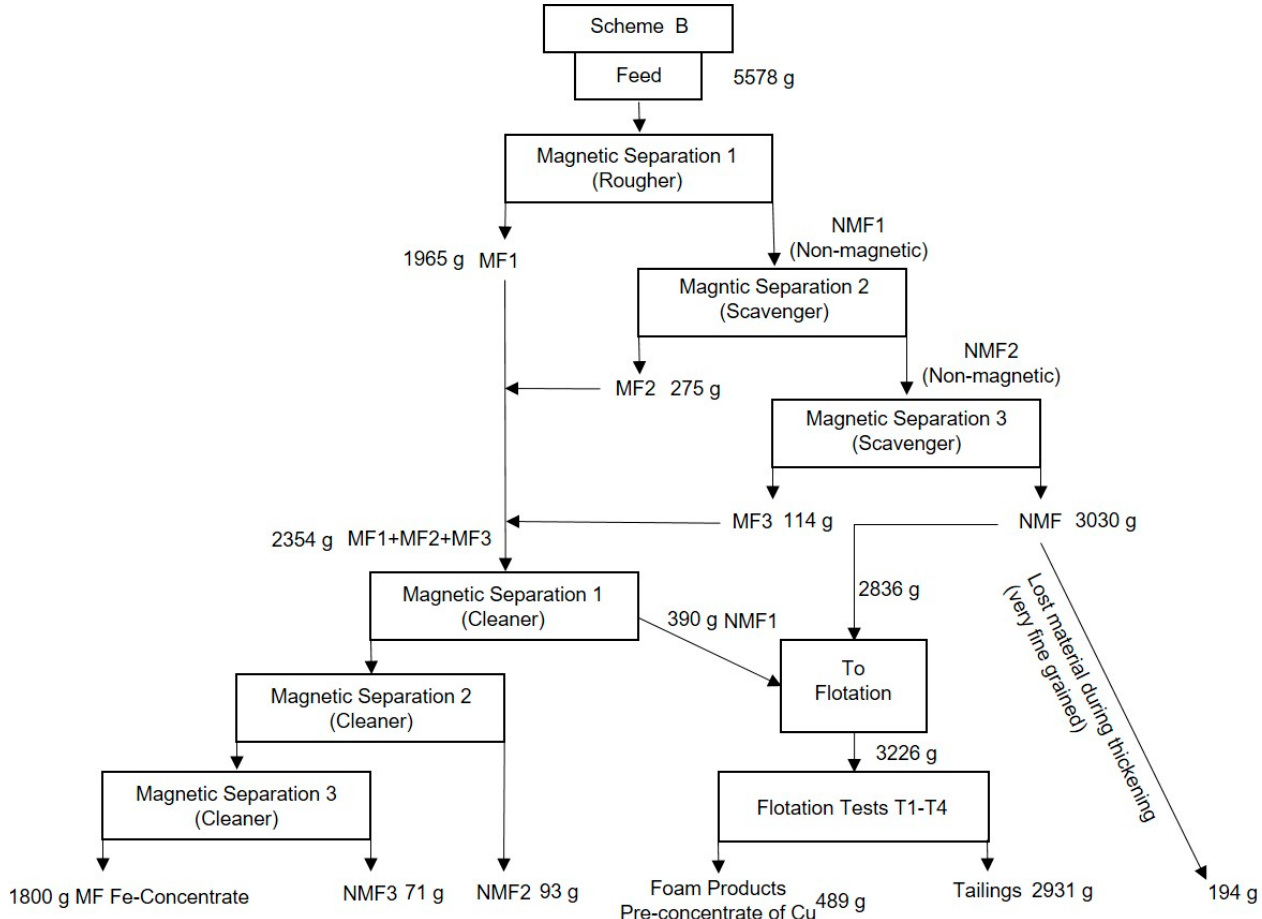
Figure 7. Processing scheme of magnetic separation with subsequent flotation. The magnetic concentrate corresponds to 32% of the mass of the fed tailings. MF: magnetic fraction, NMF: non-magnetic fraction. Table 6. Recoveries and grades for magnetic separation followed by flotation. The 194 g that were lost during thickening (Figure 7) is not shown in this table, as the geochemical composition is unknown.